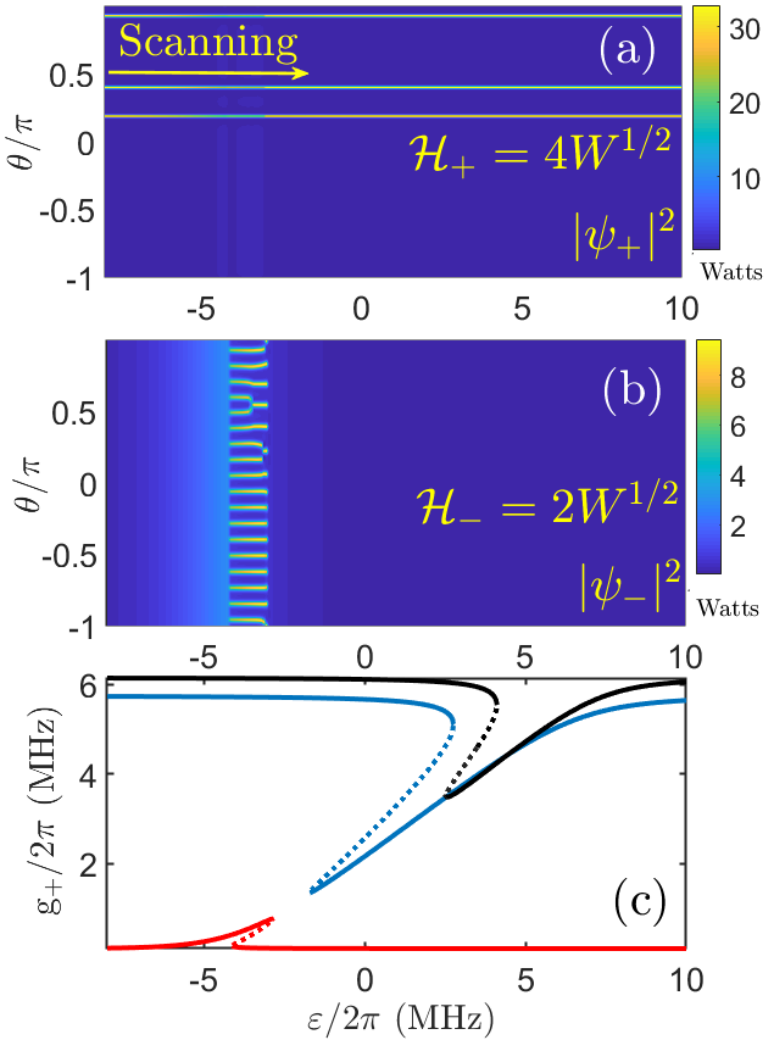
Figure 7. The forward scan performed outside the soliton-blockade conditions, H − / H + = 1/2, H − = 2W 1/2 , δ = 6 MHz (cf. Figure 3b): ( a , b ) the plus and minus fields during the scan; and 0 /2 π ( c ) g + for the cw-cw state over the same interval of ε